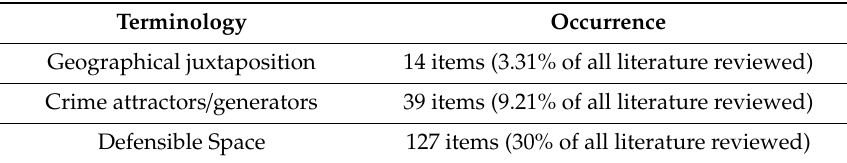
Table 2. Search Terms for the Literature